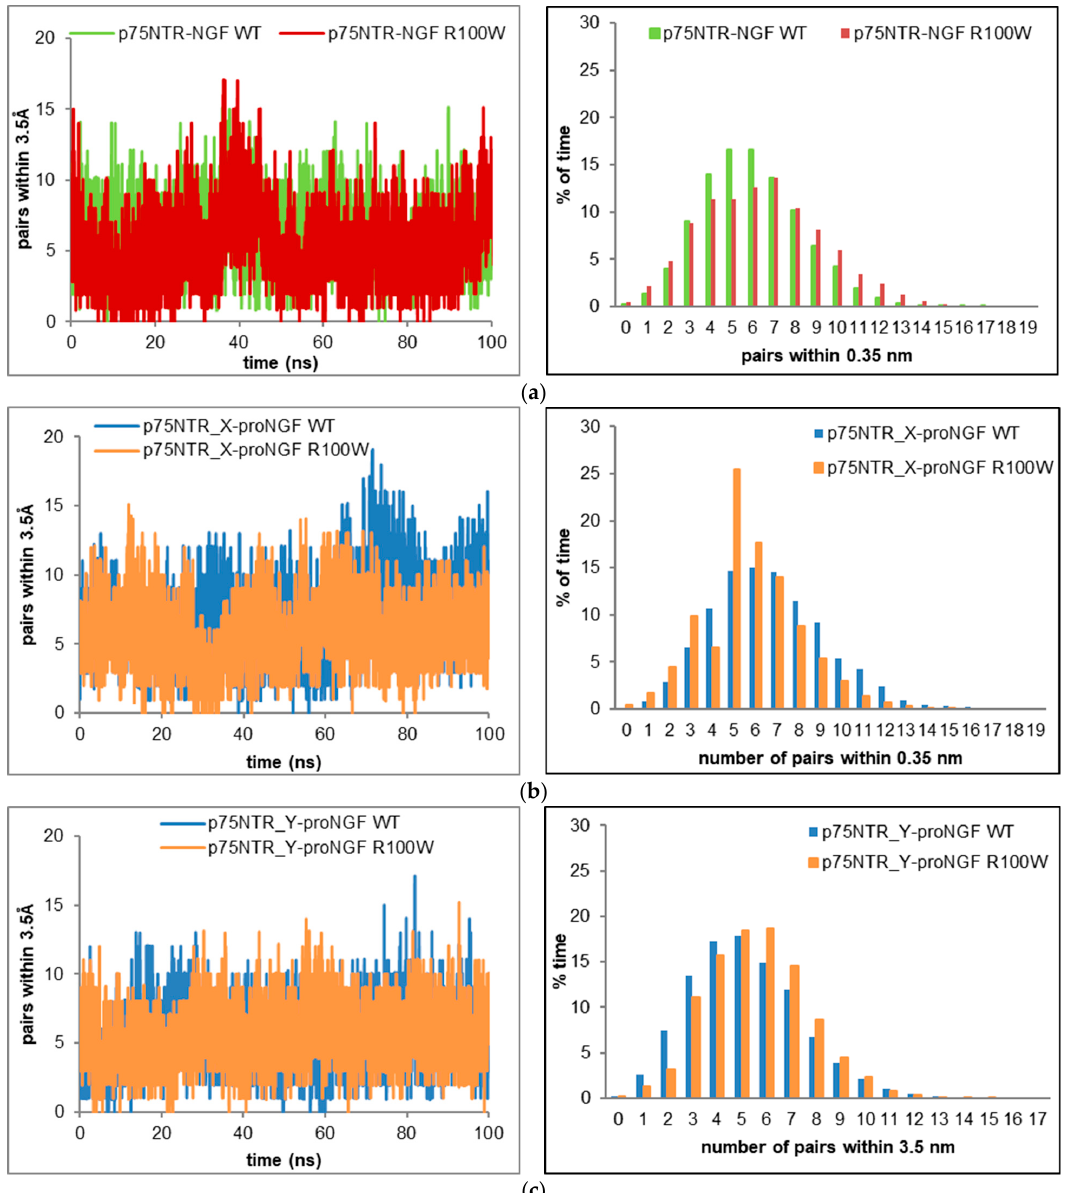
Figure 10. Plots of the number ( left panel) and percentage of time persistence ( right panel) of the intermolecular pairs within 3.5 Ă in the complexes: ( a ) p75NTR/NGF, ( b ) p75NTR_X/proNGF, and ( c ) p75NTR_Y/proNGF. ( c )